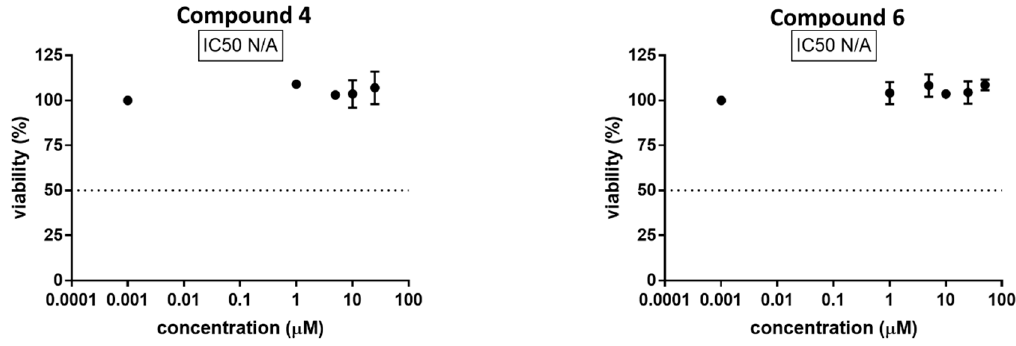
Figure 2. Cytotoxic effect of different concentrations of the tested substances on HepG2 cells. Data points from precipitated concentrations are not shown.